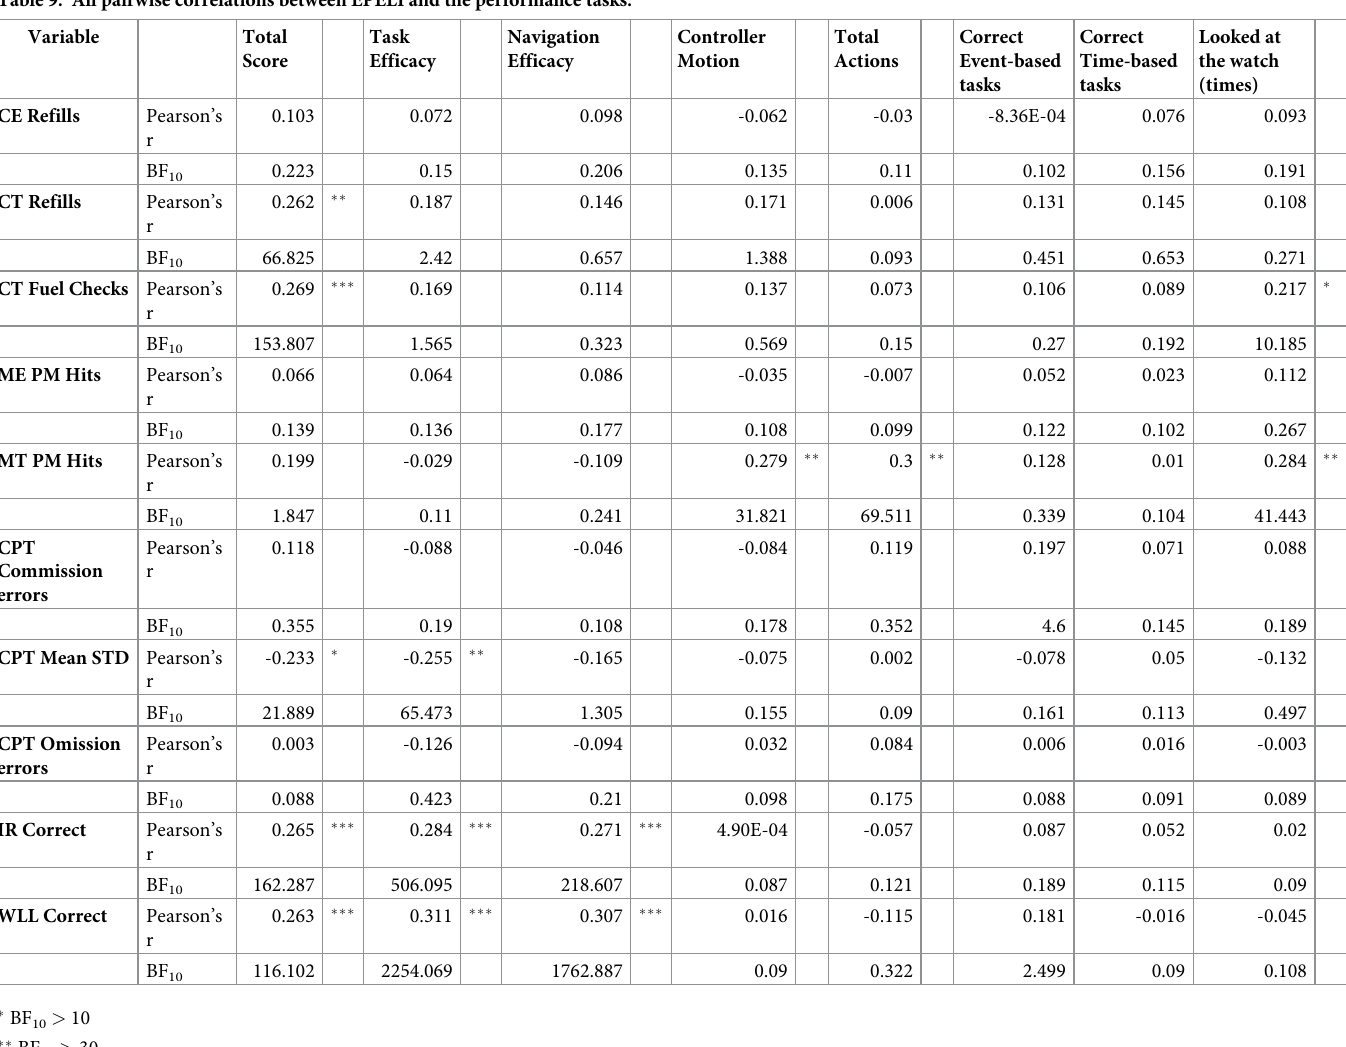
Table 9. All pairwise correlations between EPELI and the performance tasks.